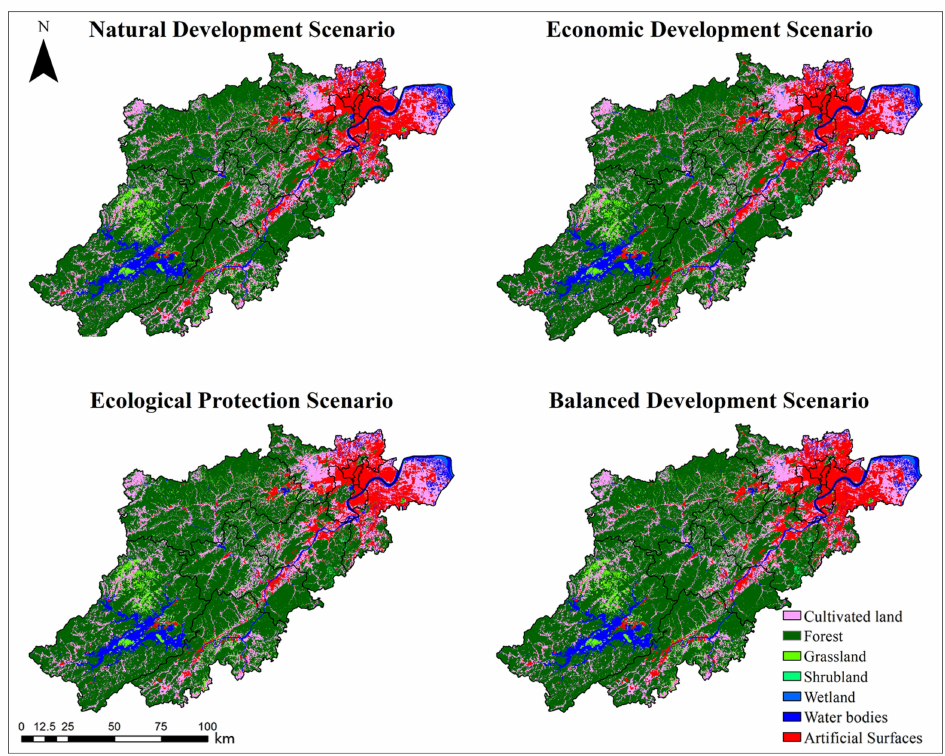
Figure 6. Simulation of the land-cover distribution in Hangzhou under the four scenarios in